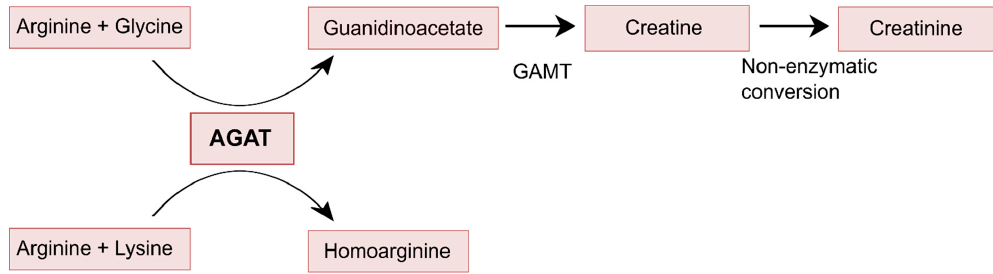
Table 1. Effect of unilateral nephrectomy on biochemical parameters in 127 healthy kidney donors. Study design and methods are described previously [51,52].